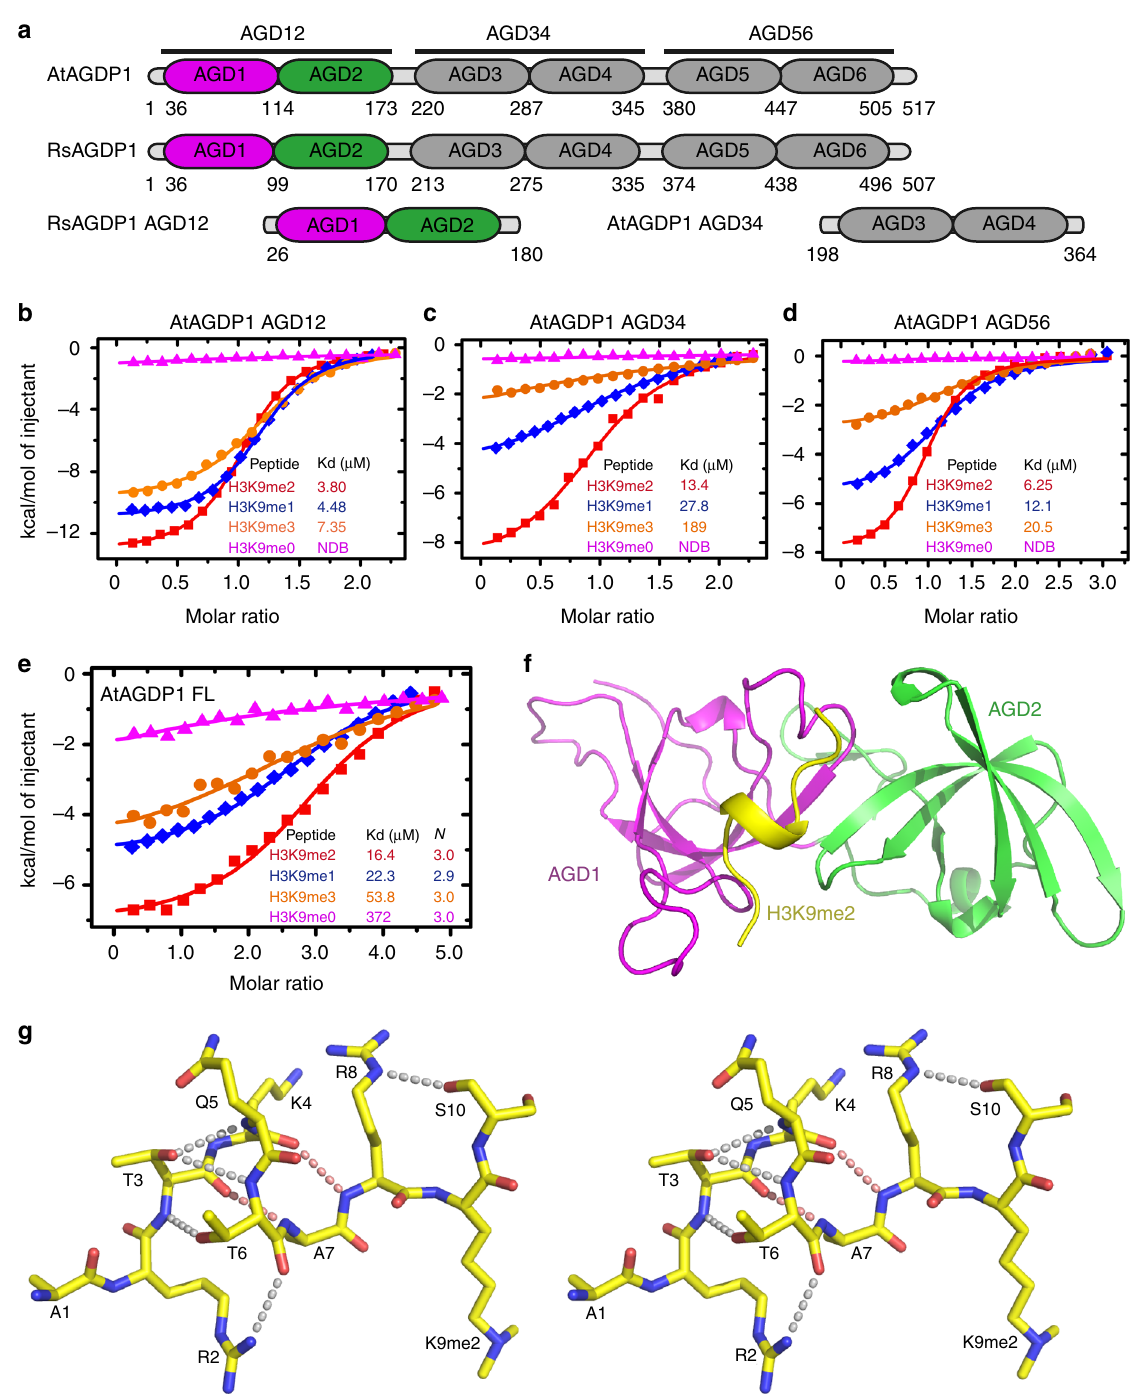
Fig. 1 Structure of the RsAGDP1 AGD12 – H3K9me2 complex. a A schematic representation of the domain architecture of AtAGDP1 (upper panel), RsAGDP1 (middle panel), and the constructs of RsAGDP1 AGD12 and AtAGDP1 AGD34 used for crystallization in this research (lower panel). b – d ITC-binding curves between different methylated H3K9 peptides and AGD12 ( b ), AGD34 ( c ), and AGD56 ( d ) of AtAGDP1 show that all three tandem AGD cassettes recognize methylated H3K9 marks with a preference on H3K9me2. NDB, no detectable binding. e ITC-binding curves between different methylated H3K9 peptides and full-length AtAGDP1 show that the full-length AGDP1 recognize methylated H3K9 with a preference on H3K9me2 and the bindings have a binding ratio near 3. FL, full-length. f The overall structure of the RsAGDP1 AGD12-H3K9me2 complex is shown in ribbon diagram with the AGD1, AGD2, and H3K9me2 peptide colored in magenta, green, and yellow, respectively. The peptide adopts a unique helical conformation. g A stereo view of the intra- molecular hydrogen-bonding interactions within the H3K9me2 peptide. The main chain – main chain hydrogen bonds and side chain – main chain hydrogen bonds are highlighted by dashed red and silver lines,